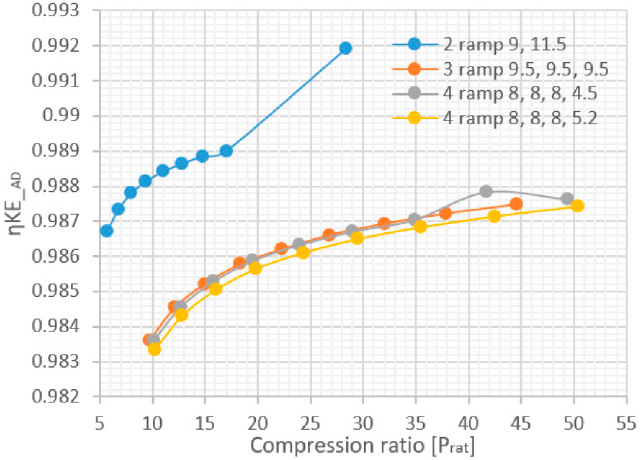
Figure 19. Adiabatic efficiency of inlets for different ramp configurations.